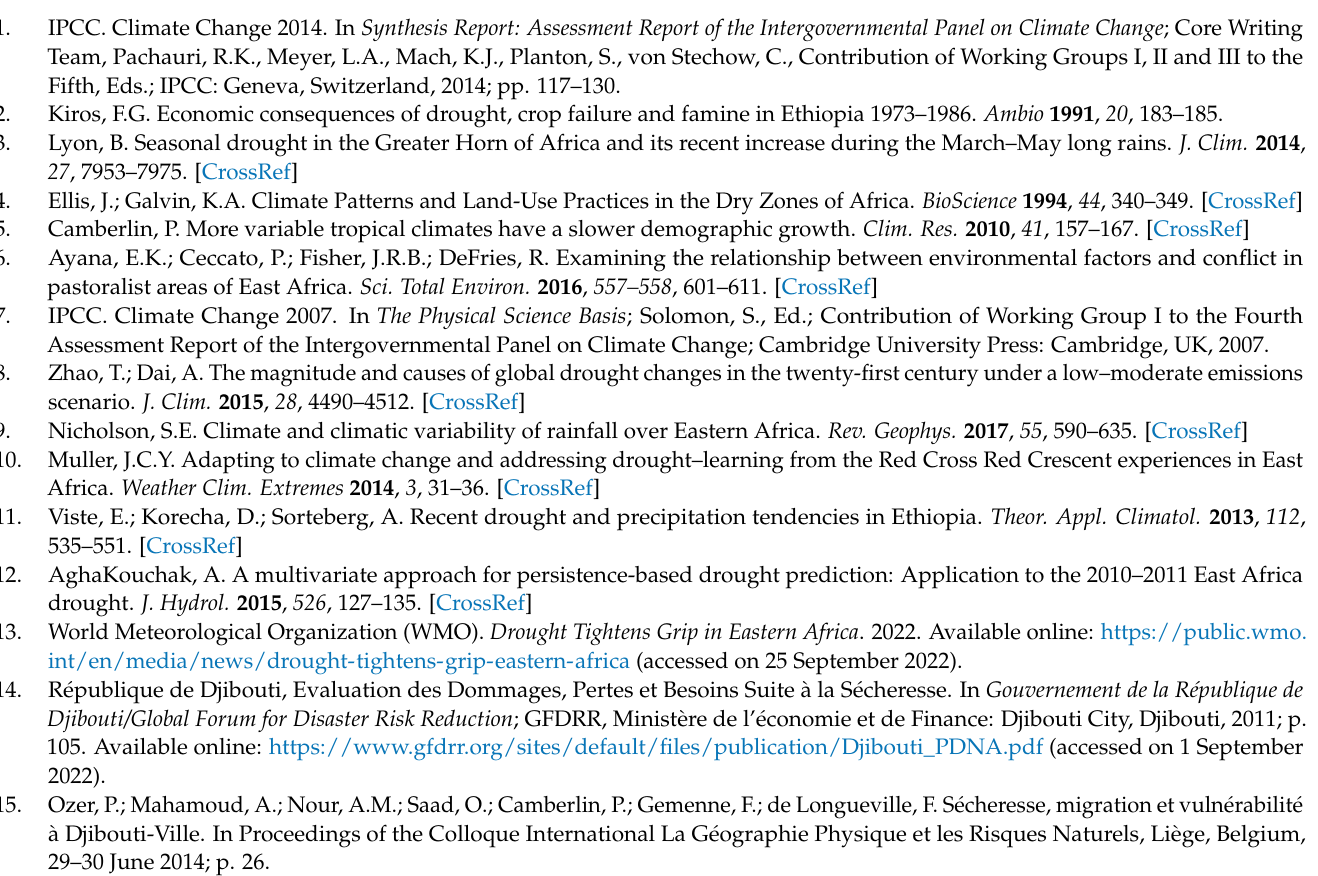
2021, as presented in Figure 7. Figure S4: Seasonal ((a) JF, (b) MAM, (c) JJAS, and (d) OND) and (e) annual variability of the SPEI over the period 1961–2021 at the Djibouti Airport station. Figure S5: Interannual variations and linear trends of the annual mean of the SPEI (3, 6, 9, 12, and 24 months) at the Djibouti Airport observation station during